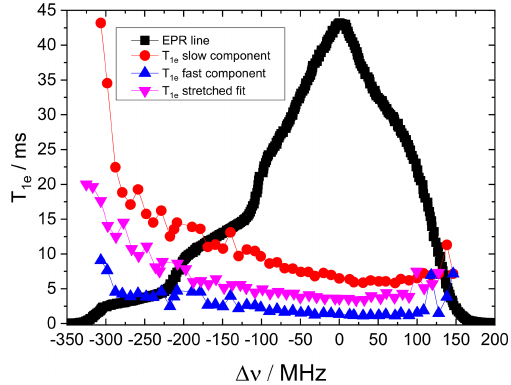
Figure 6. The frequency dependence of T 1e of 10mM TEMPOL at 20K, measured every 10MHz . Each point corresponds to a mea- surement fitted with a bi-exponential fit as noted on the